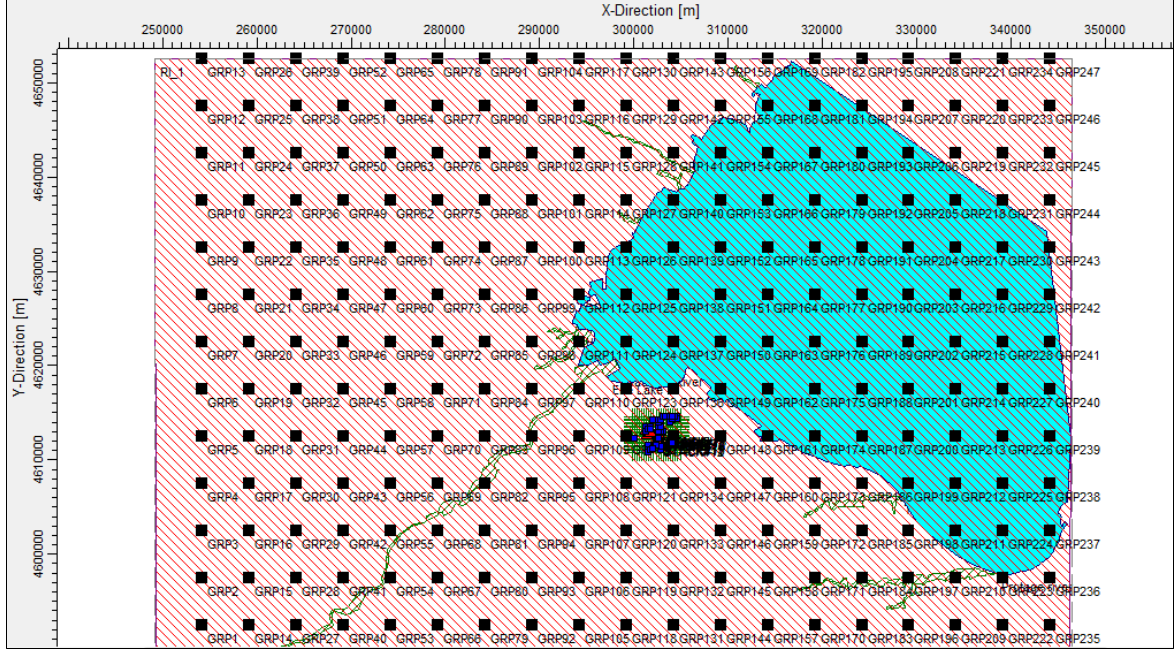
Figure 2. Receptor location identified by IRAP model.